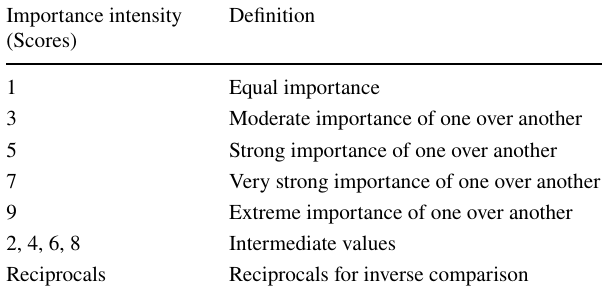
Table 1 Possible losses in the study area for Q